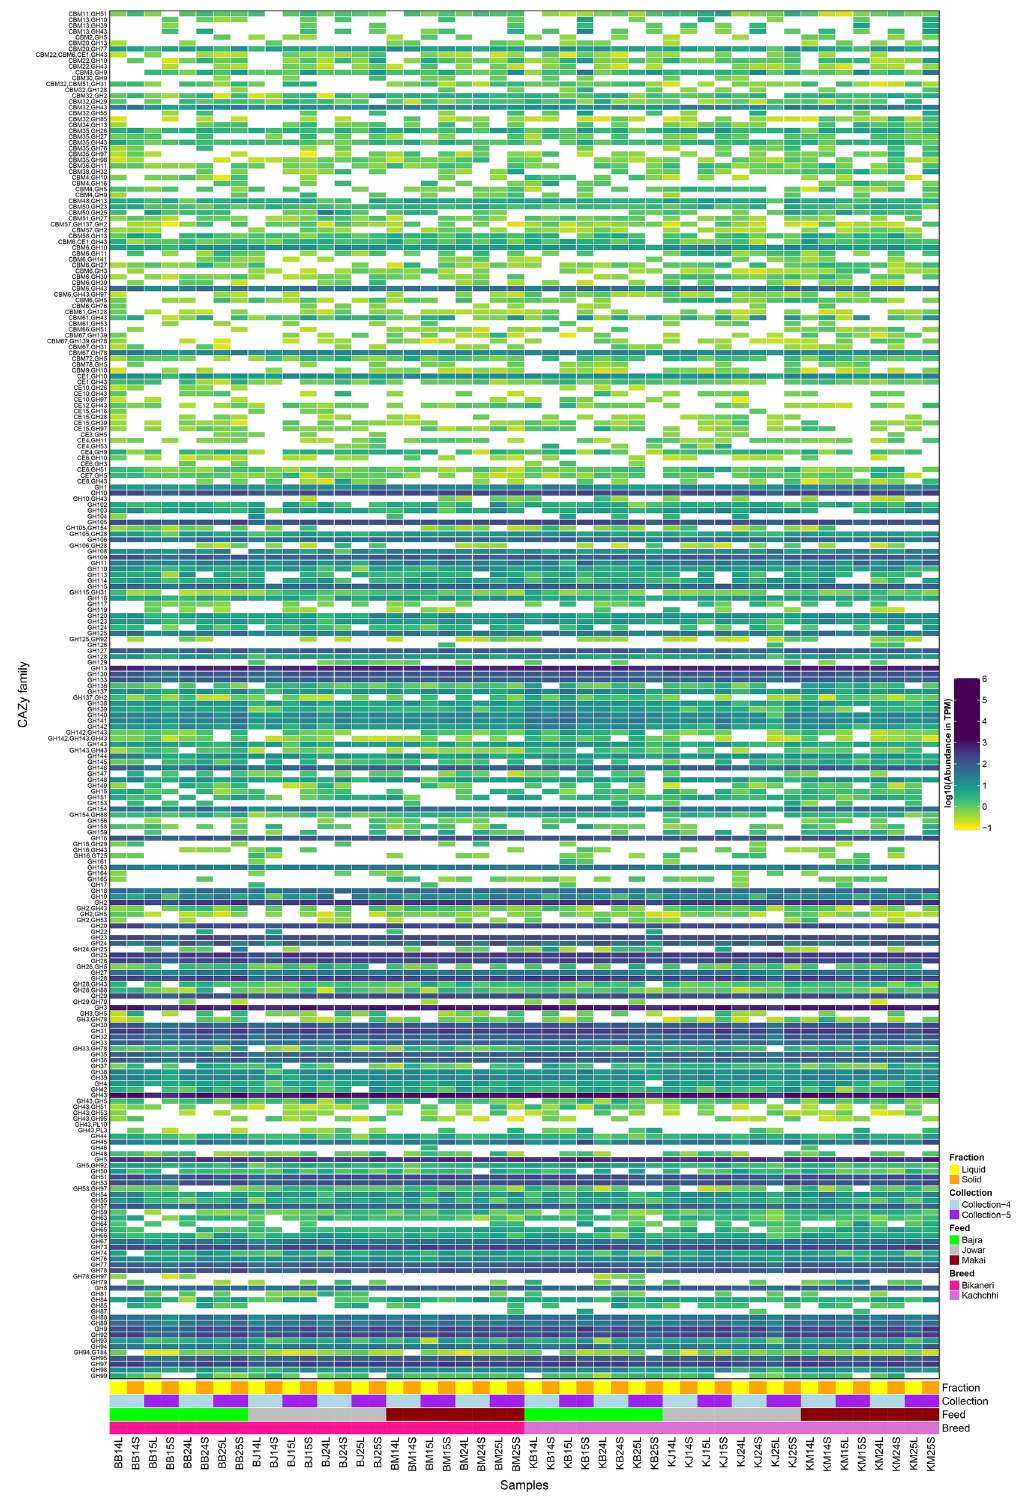
Figure 6. Heatmap showing distribution of all the CAZyme categories which were annotated to contain at least one GH